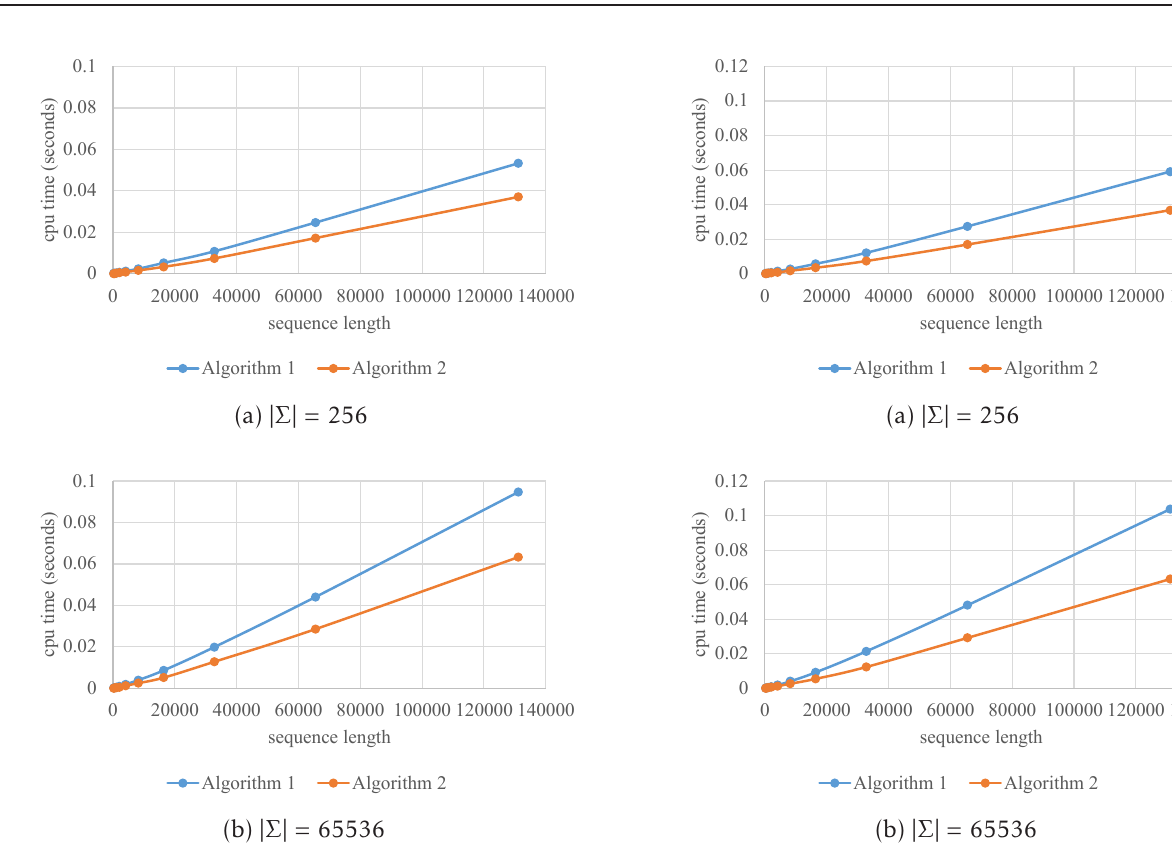
Algorithm 2 is consistently faster than Algorithm 1,